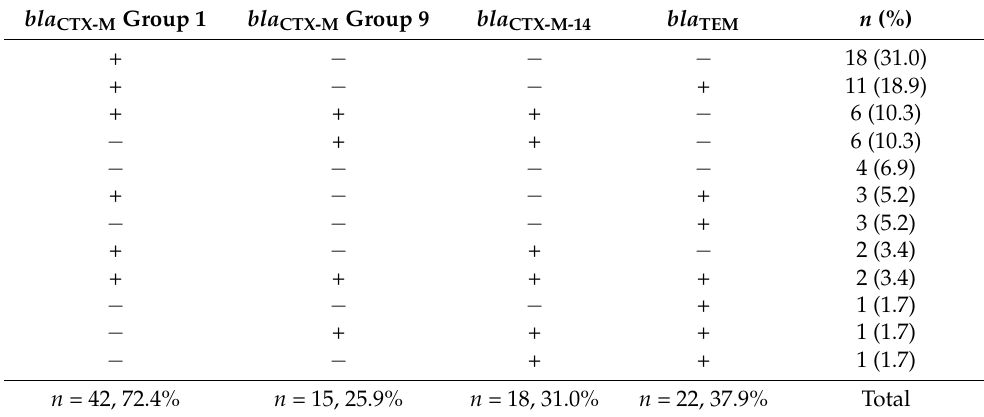
Table 2. Types of ESBL genes detected among ESBL-producing uropathogenic E. coli isolates ( n = 58).